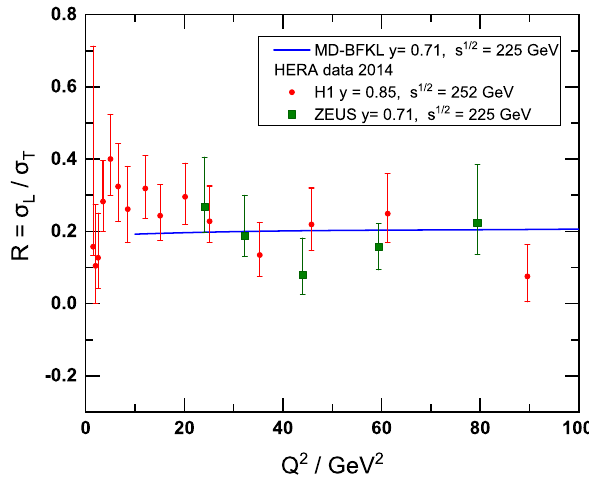
Fig. 16 pQCD prediction from KC improved MD-BFKL for the ratio R ( Q 2 ) in the kinematic range 2 GeV 2 ≤ Q 2 ≤ 100 GeV 2 . The data √ √ s = 252 GeV) and ZEUS ( s = 225 GeV) exper- [57] are from H1 ( √ s = 225 GeV analogous to iment. The theoretical calculation are for c.m.s. of ZEUS